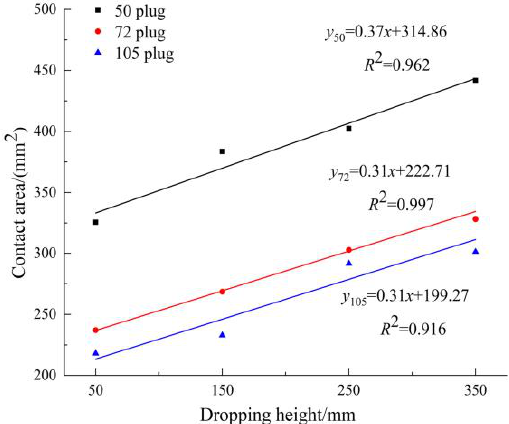
Figure 13. The relationship between the contact area and the drop height of different plug specifi- cations.